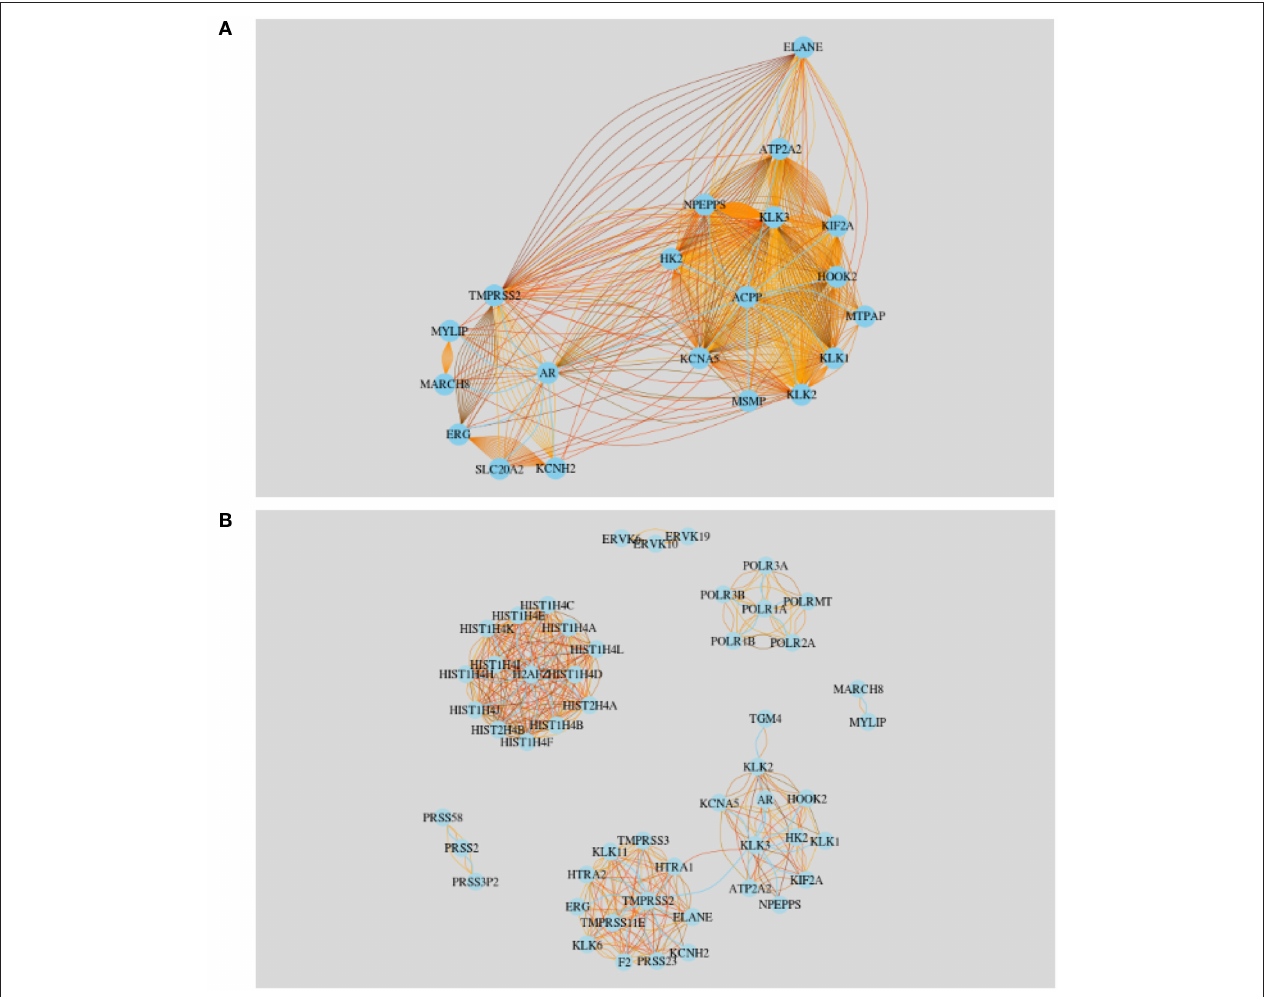
FIGURE 8 | Literature based gene-gene network for Finland. (A) Twenty most frequently studied genes in Finland. (B) Community network resulting from all studied genes in Finland.